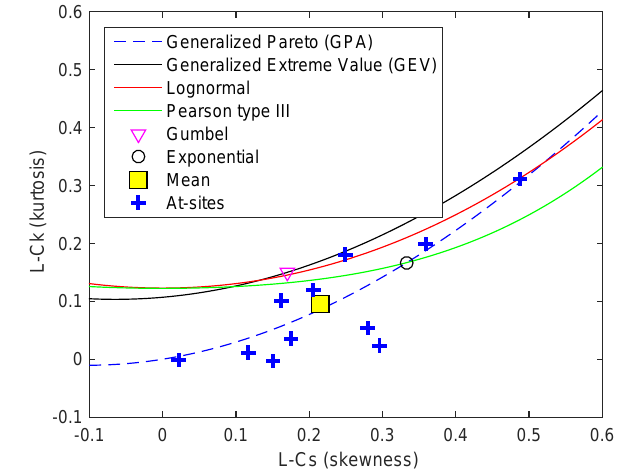
Figure 3. L-moment ratio diagram of 11 rain gauges (at-sites) and regional rainfall data (mean) for selecting the best-fit frequency dis- tribution.